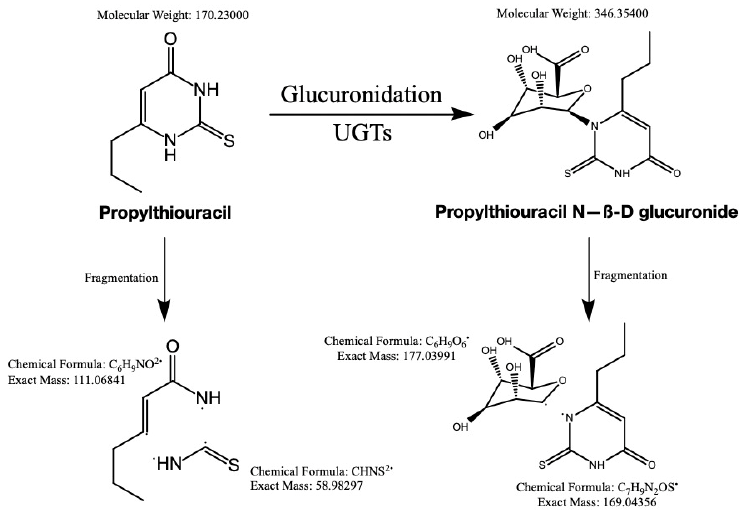
Figure 3. The structure of PTU and PTU-GLU, along with proposed fragmentation pathways.